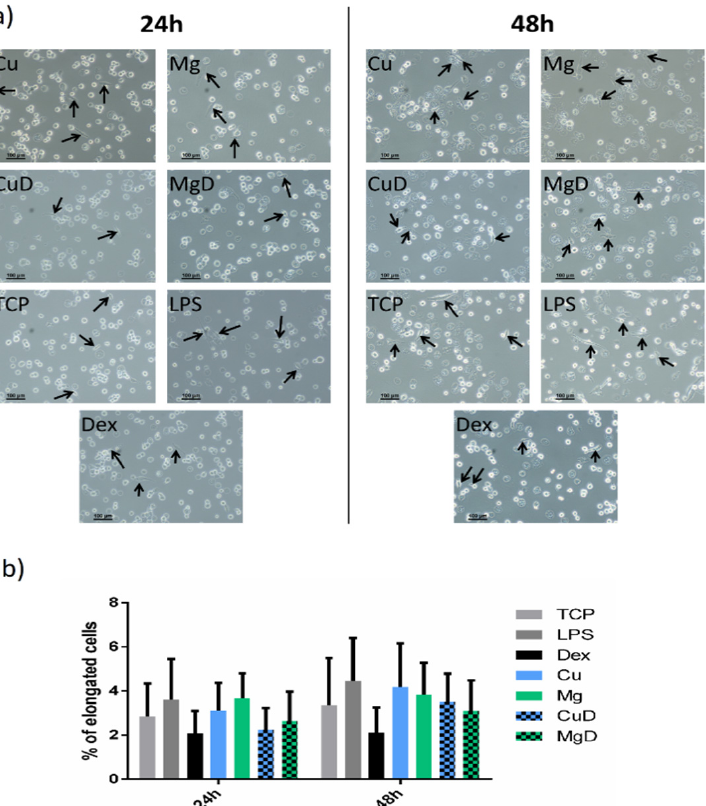
Figure 2. Effect of dex and the combination of dex with Cu 2+ and Mg 2+ on THP-1 cell morphology. ( a ) Elongated cells, which were defined as those in which the aspect ratio was higher than 2.5, are indicated with black arrows. Scale bars = 100 µ m. ( b ) Quantitative analysis of THP-1 cell morphology. The number of elongated cells (aspect ratio higher than 2.5) in each condition was